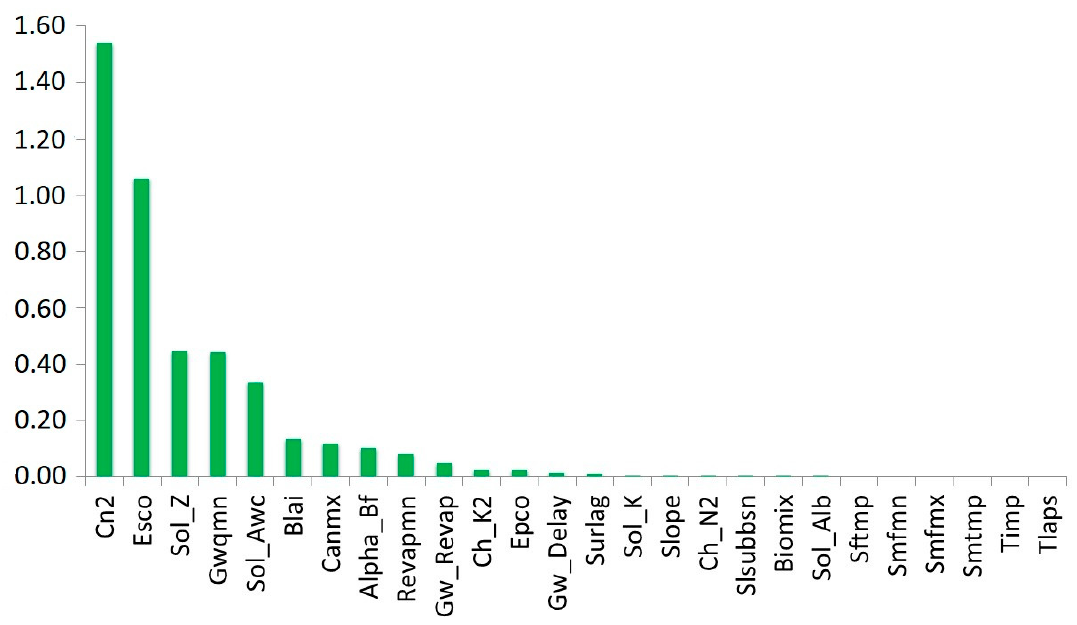
Figure 8. Results of the sensitivity analysis performed on the SWAT model parameters for the Santa Catalina Basin.